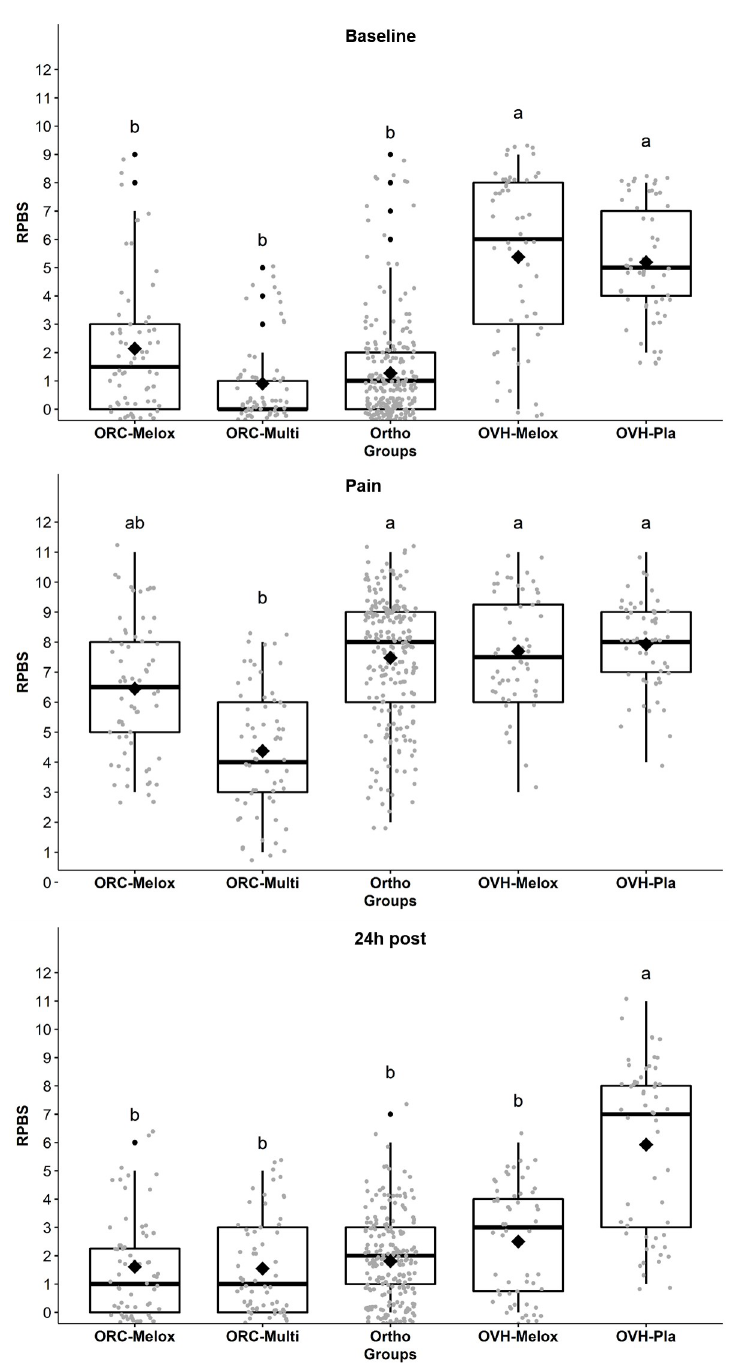
Fig 4. Box-plot of the scores (median/amplitude) of the RPBS (rabit pain behaviour scale), comparing the groups at each perioperative time point. The top and bottom box lines represent the interquartile range (25 to 75%), the line within the box represents the median, the extremes of the whiskers represent the minimum and maximum values, black lozenges ( ♦ ) represent the mean and black circles (•) represent outliers. RPBS: Rabbit pain behaviour scale. Different letters express significant differences between groups where a > b, according to the mixed linear model